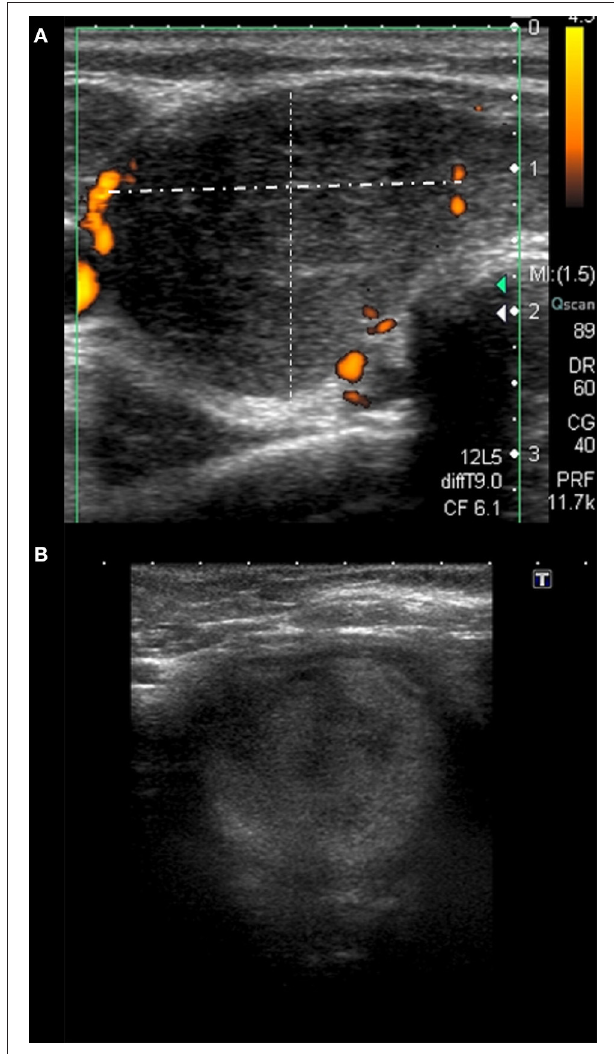
FIGURE 2 | Different sonographic pattern observed in patient with HLA-B*18:01 only. (A) Homogeneously hypoechoic single area filling the whole right lobe; (B) moderately hypoechoic single SAT area filling the whole thyroid lobe, mimicking a nodule affecting the whole